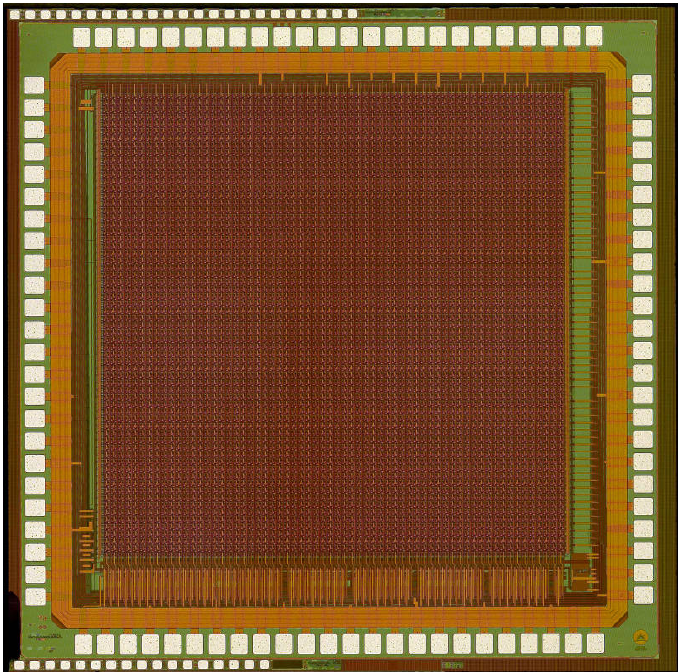
Figure 14. Photograph of the completed